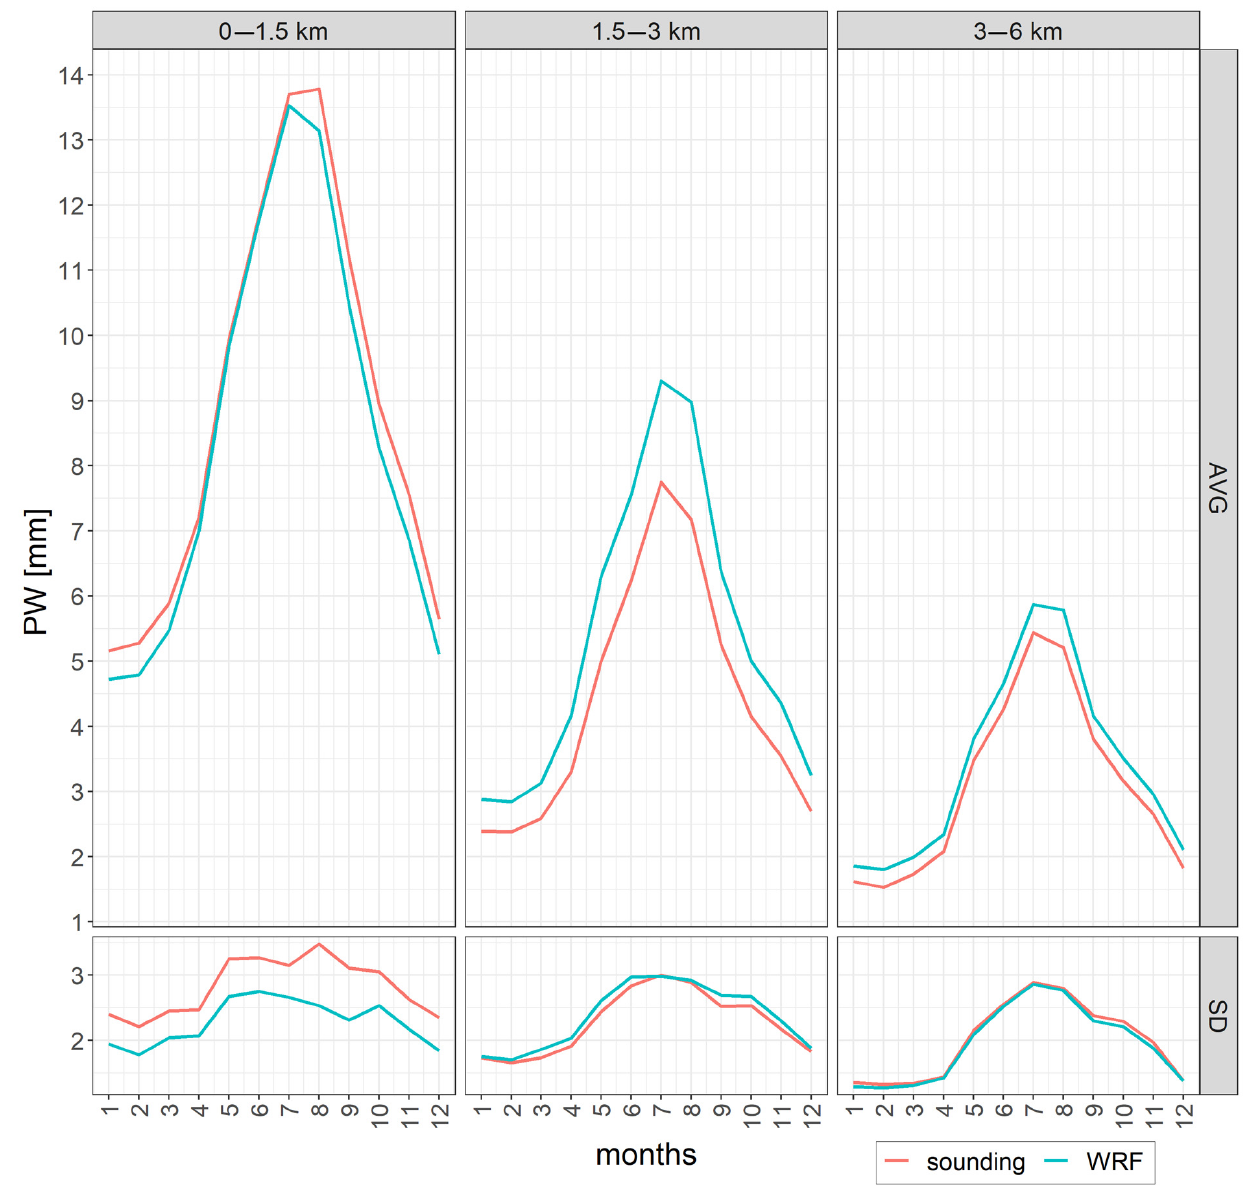
Figure 3. Monthly mean (AVG) and standard deviation (SD) of PW (mm) from the WRF model and soundings for individual levels of the troposphere in the years 2001–2010.